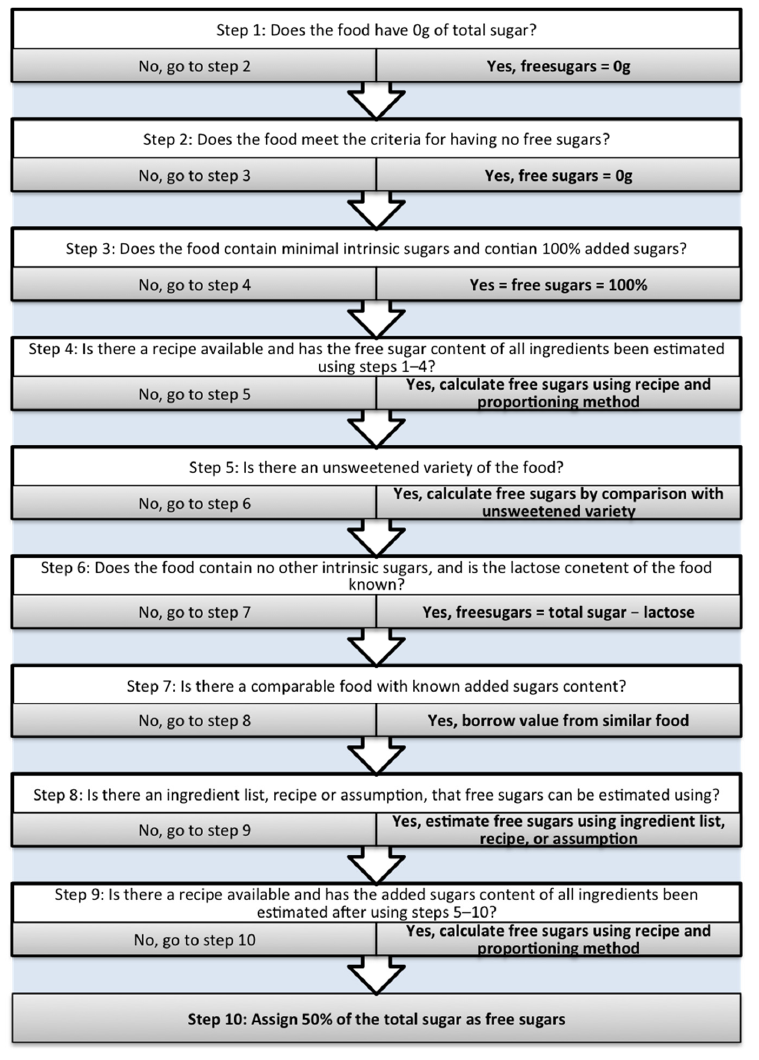
Figure 1. 10 ‐ step method for estimating free sugars content. Figure 1. 10-step method for estimating free sugars content (adapted from Louie et al. 2015